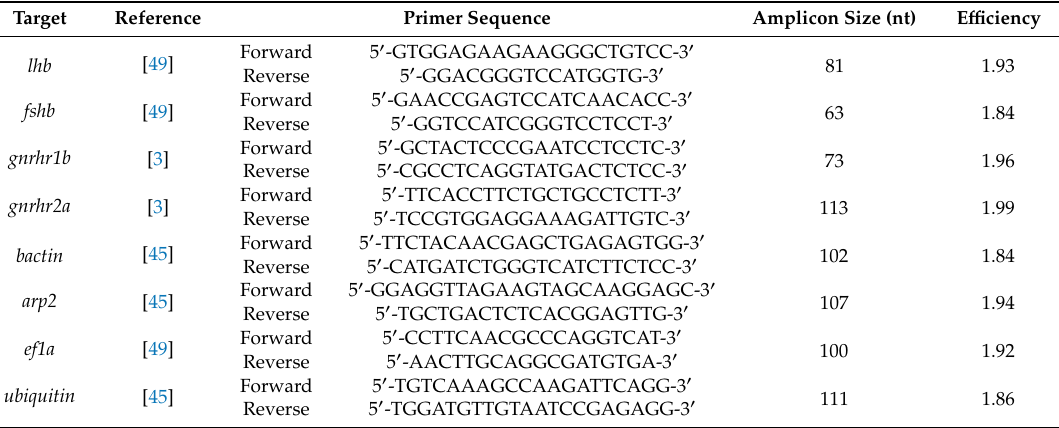
Table 1. qPCR primers used in the present